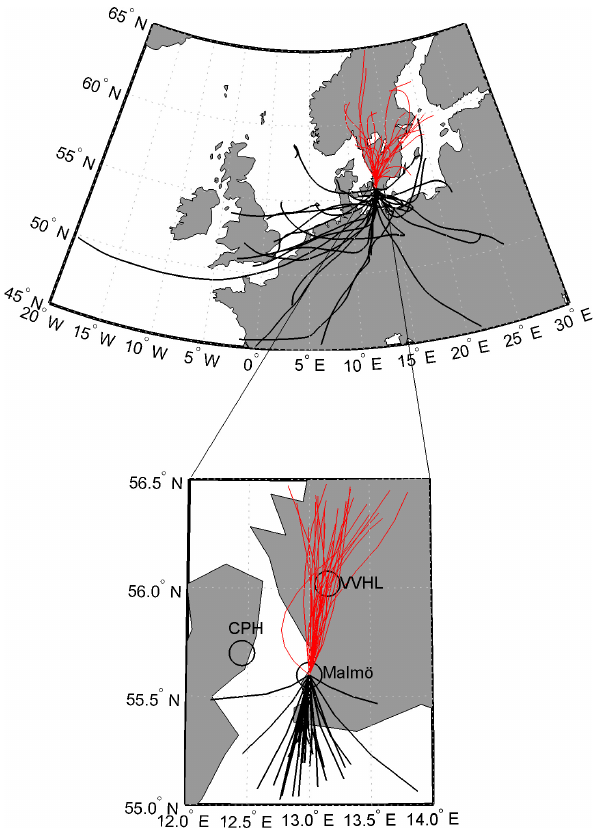
Fig. 2. 24 h forward trajectories (red) and 48h backward trajecto- ries (black) with starting point in Malm¨o for all the 26 urban plume cases. Vavihill (VVHL), Malm¨o and Copenhagen (CPH) are illus- trated with